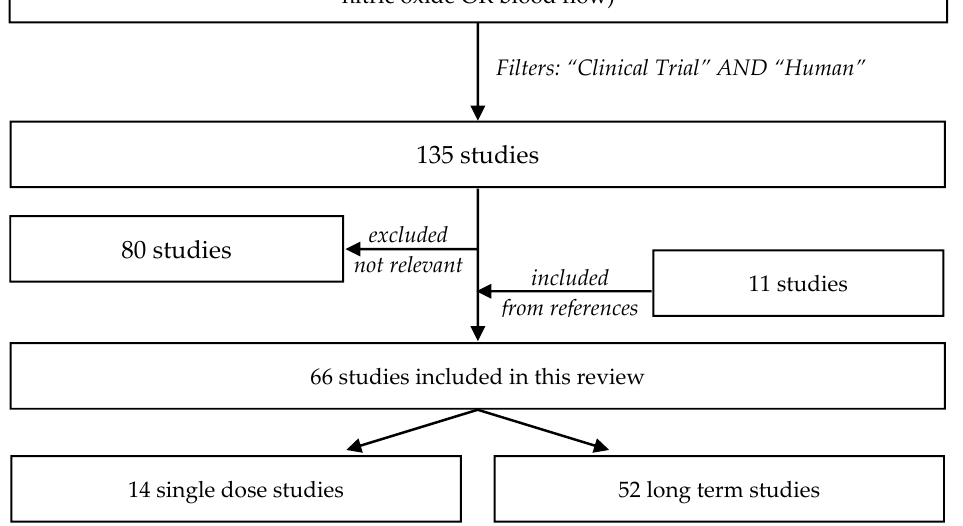
Figure 1. Flow chart describing the literature search process. The literature search was conducted on PubMed, ScienceDirect, and Web of Science databases and limited to original clinical trials with human participants published after January 1st, 2005. One-hundred-and-thrity-five abstracts and full texts were reviewed. Eighty studies not reporting both ACN source and blood pressure markers were excluded. Eleven additional relevant studies were identified during the screening process from the reference lists, and were added to the review.